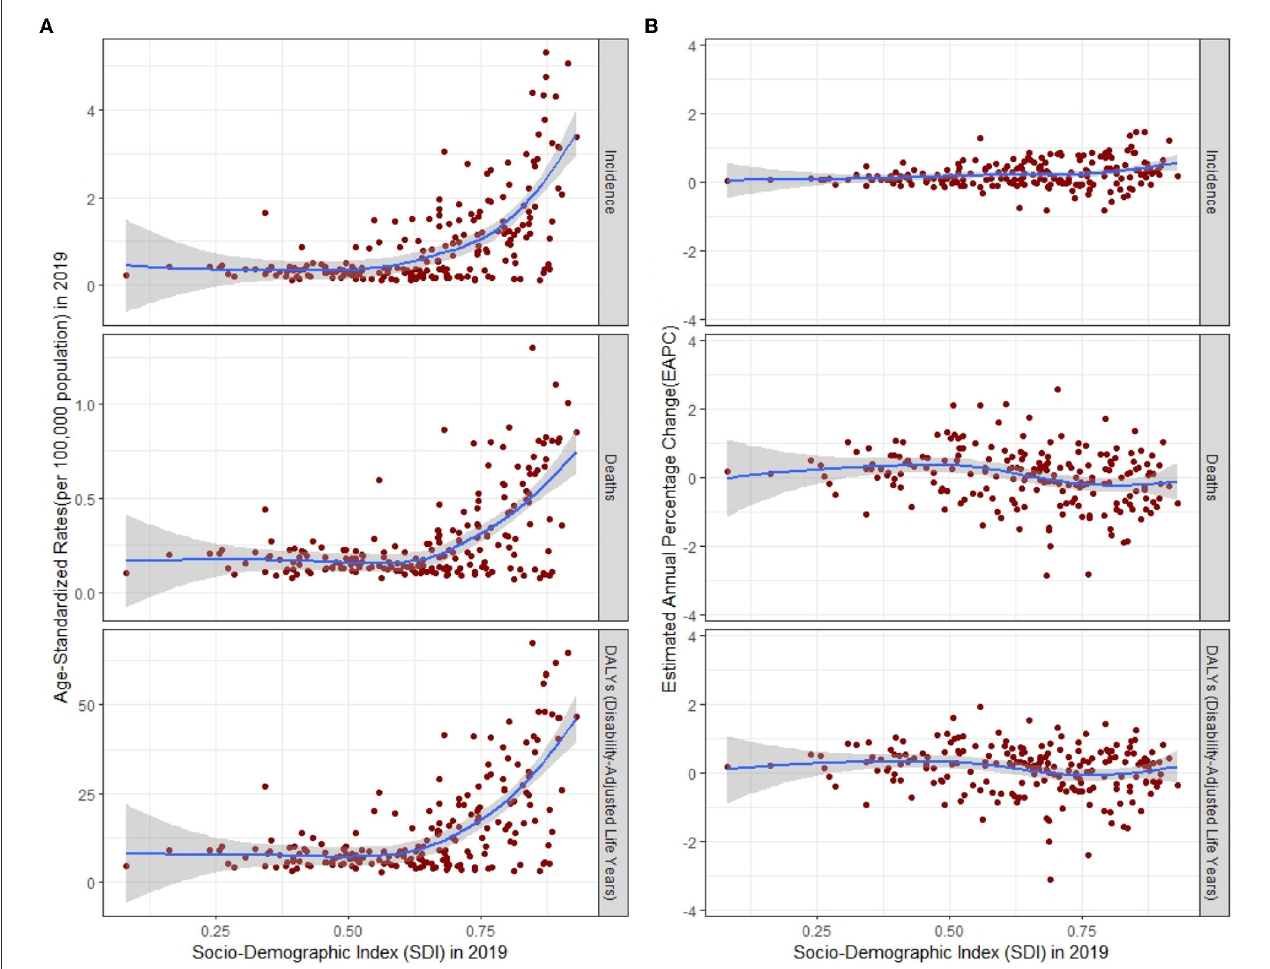
FIGURE4 ASR (A) and its EAPC (B) of incidence, deaths, and DALYs for multiple sclerosis by SDI, 1990–2019, expected value-based SDI. The blue line represents the average expected relationship between SDI and corresponding disease burden indicator values. ASR, age-standardized rates; EAPC, estimated annual percentage change; DALYs, disability-adjusted life years; SDI, Socio-demographic